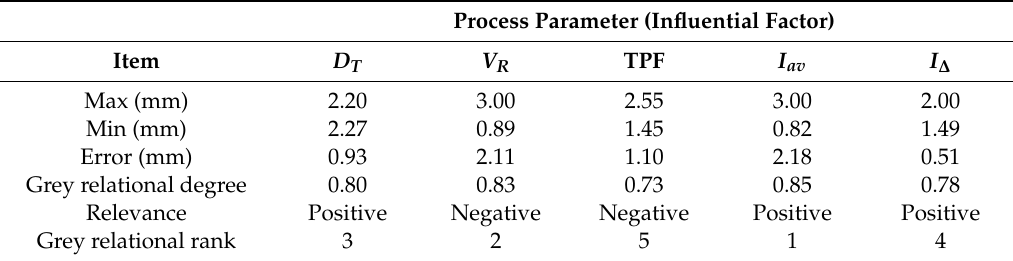
Table 7. Grey relational analysis about the penetration H.